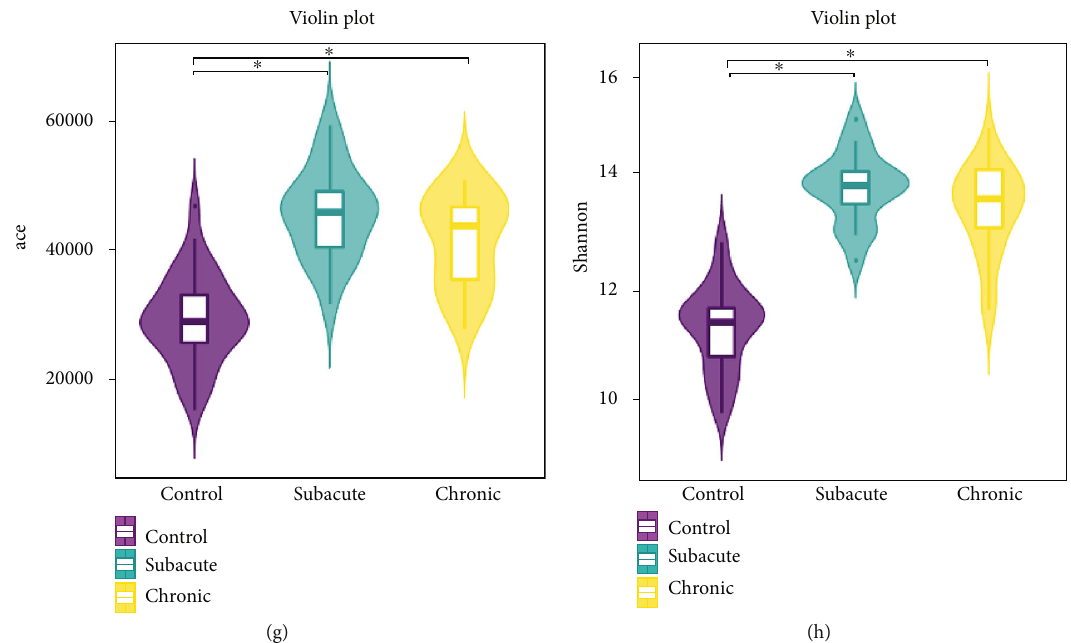
Figure 4: Subgroup analysis of gut microbiota in stroke. (a) Correlation network in the control group. (b) Correlation network in the poststroke group. (c) Correlation network in the subacute patients. (d) Correlation network in chronic patients. (e) OTU bubble plot indicated di ff erences in genus level between subgroup of poststroke patients and control group. (f) LDA scores for di ff erentiated bacterial taxa are abundant between the subacute and chronic patients ( LDA score > 2 : 5 ). Red bars indicate taxa enriched in the chronic group; green bars indicate taxa in the subacute group. (g, h) Alpha diversity is estimated with the ace and Shannon index. OTU: operational taxonomic unit; LDA: linear discriminant analysis. ∗ p < 0 : 05